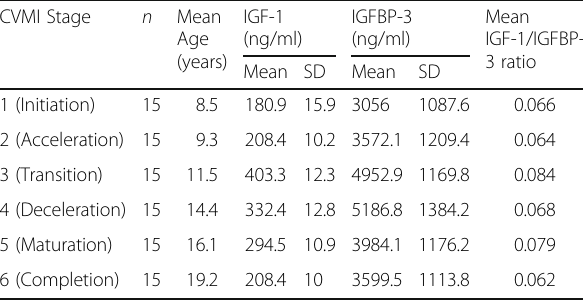
Table 1 Means and standard deviations of serum IGF-1, IGFBP-3 and their ratio at each CVMI